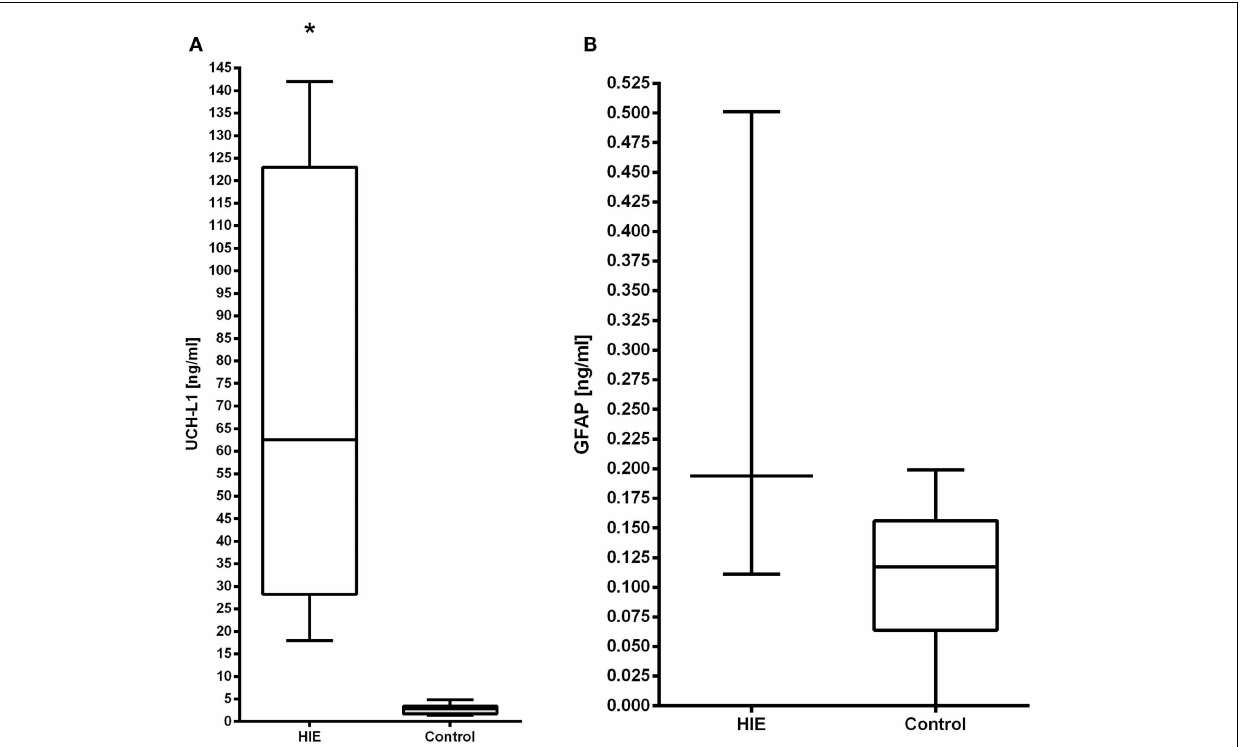
FIGURE 1 |The serum concentrations of UCH-L1 (A) and GFAP (B) in neonates with HIE are compared with control neonates . Increased serum levels of UCH-L1 at 0–6h in HIE patients ( n = 4) compared with controls ( n = 11), p < 0.0001.The serum concentration of GFAP did not differ statistically from the control population.